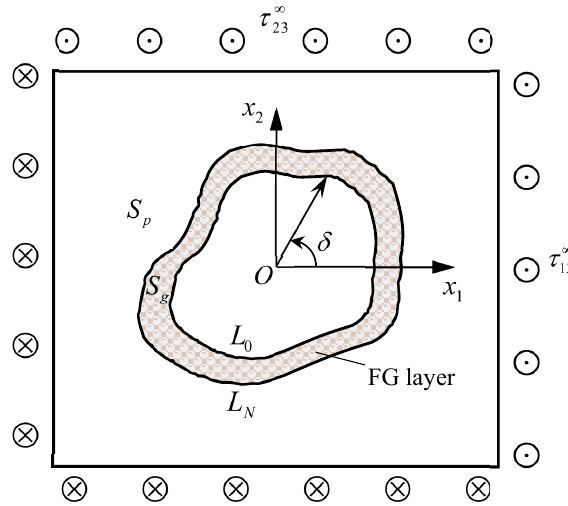
Figure 1. An infinite plate with an arbitrarily shaped hole reinforced with a functionally graded (FG) layer under anti-plane shear.